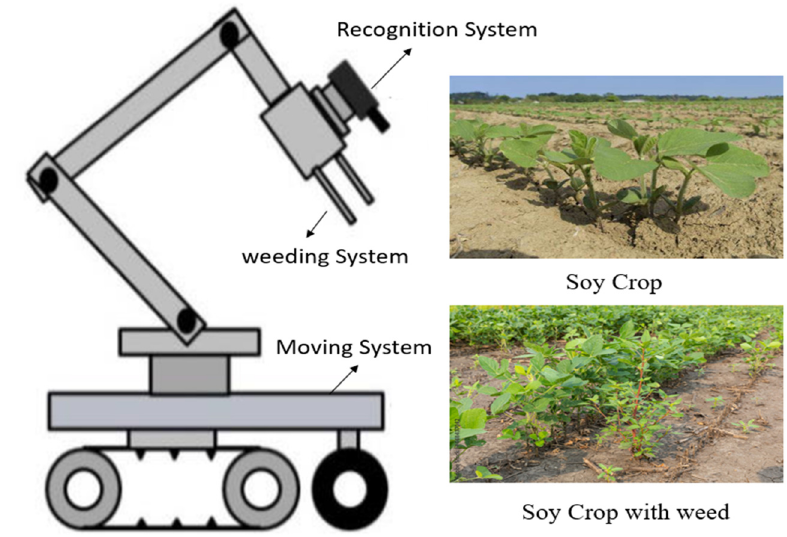
Figure 1: IoT - Fog computing - enabled robotic system for the classi fi cation of weeds and soy